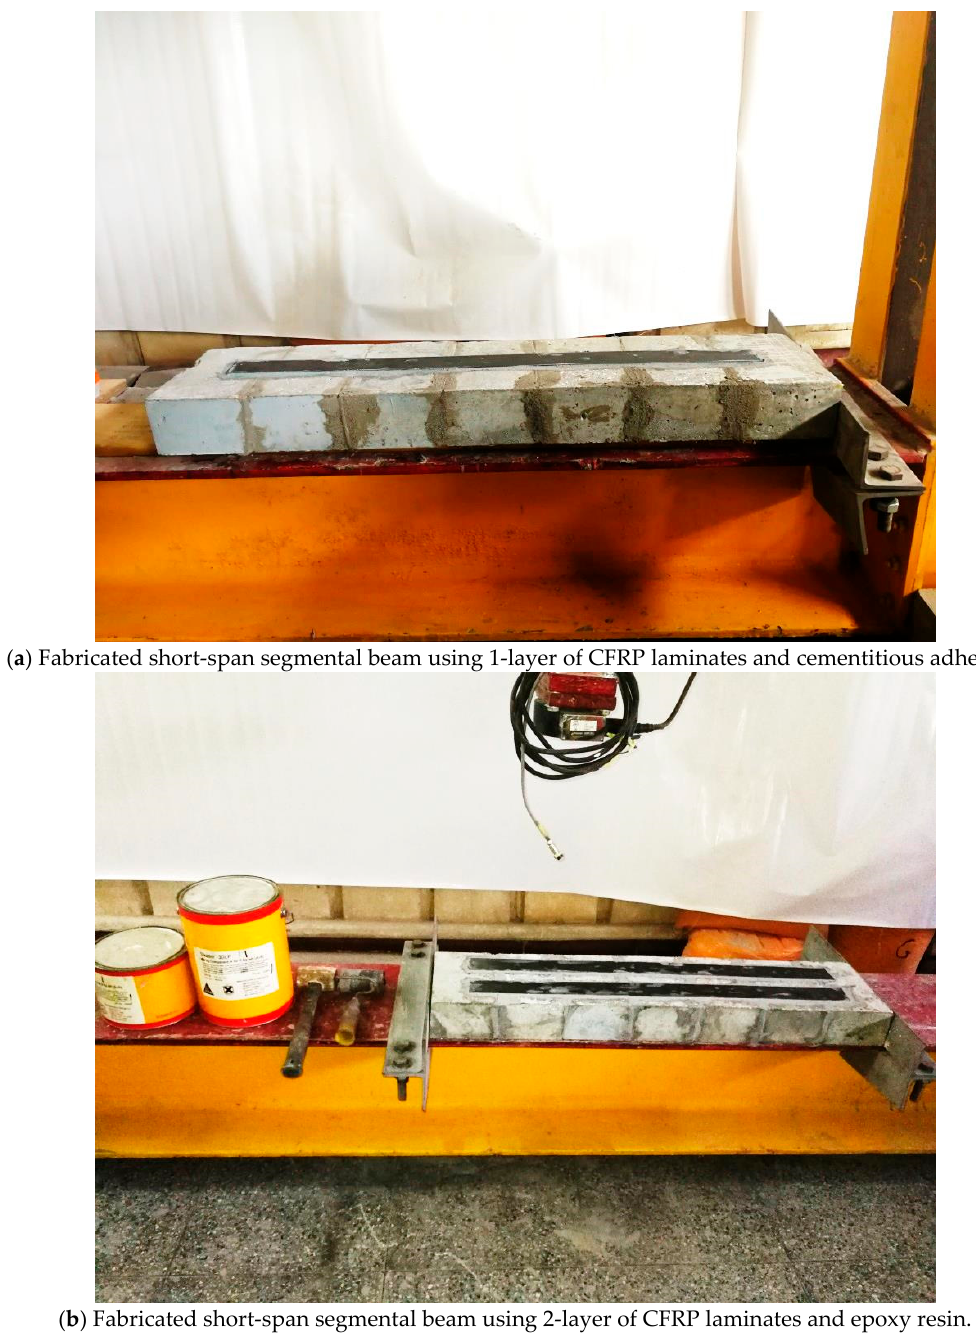
Figure 5. Fabrication of segmental beams.